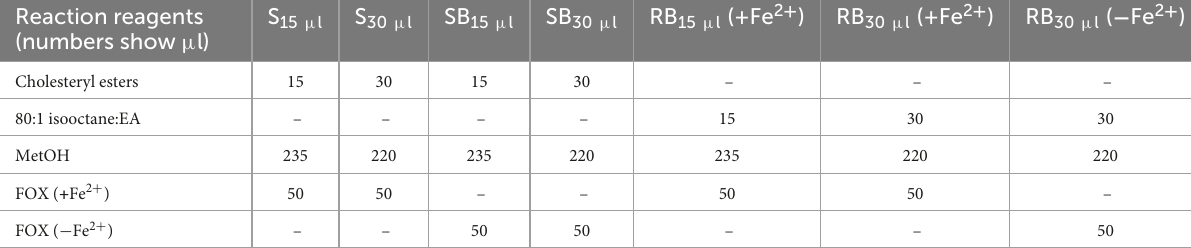
TABLE 1 Assay set up for LOOH determination in LDL cholesteryl esters. Reaction reagents (numbers show µ l)